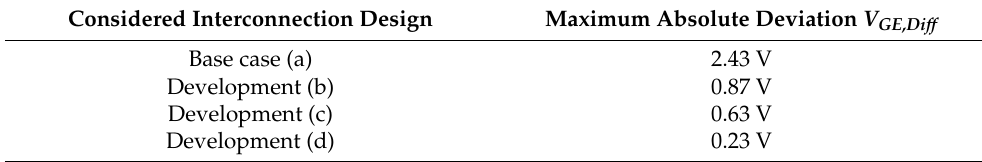
Table 3. Maximum absolute values of deviation between the master V GE and the slaves’ V GE for the interconnection options of the base case (a) and the subsequent further developments (b–d).